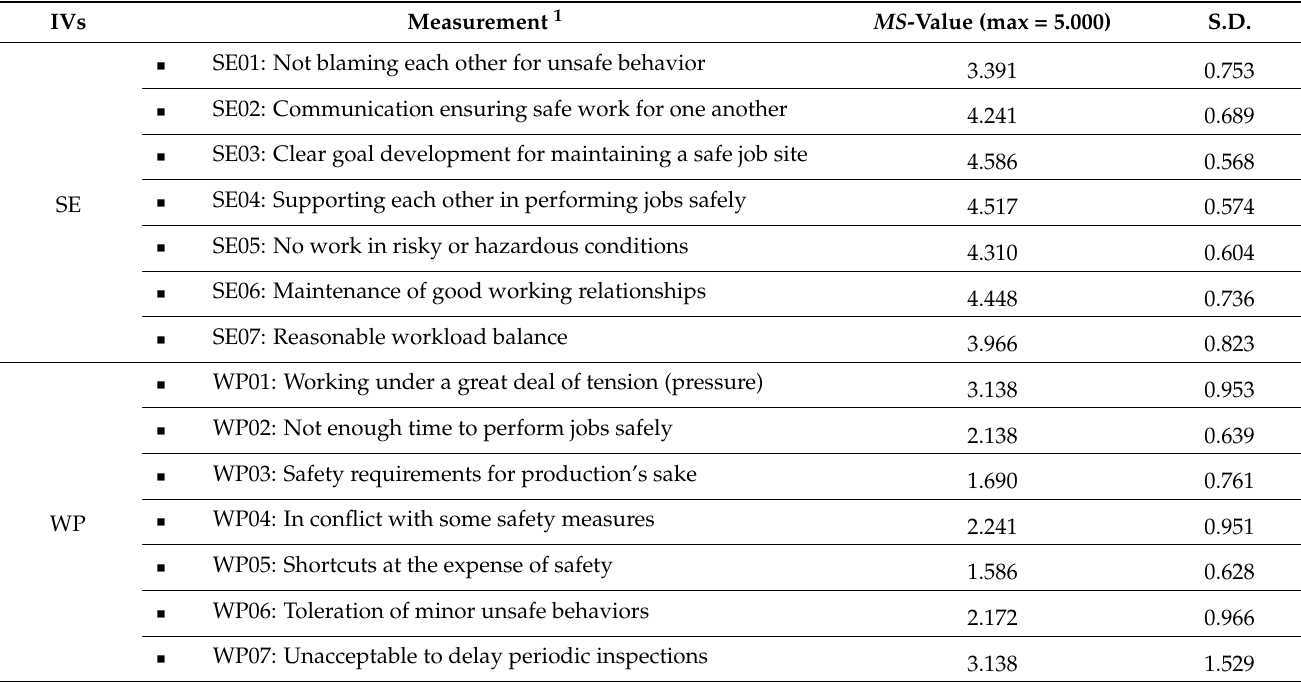
Table 8. Importance of ComP Measurements in Model 3 (Adopted from Mohamed, 2002 [8]).